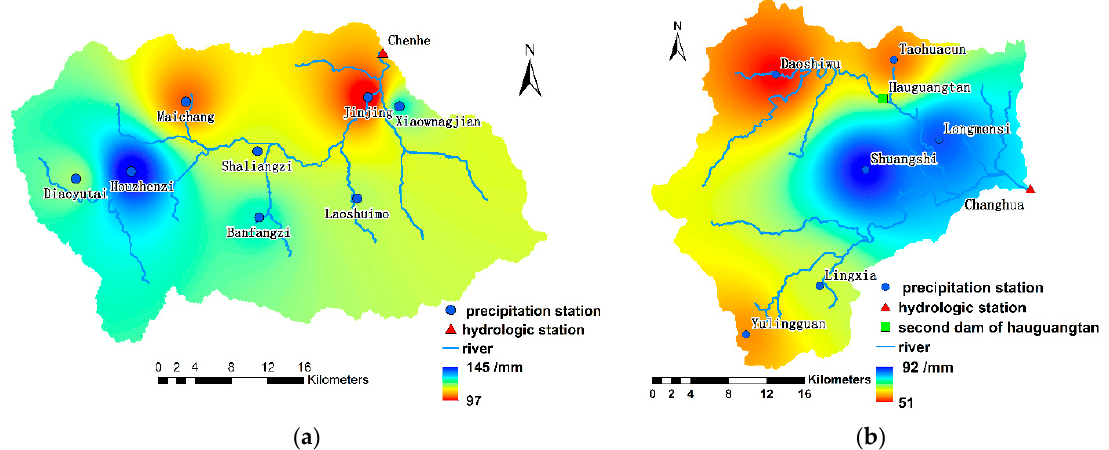
Figure 7. Rainfall distribution during the flood periods: ( a ) 3–9 September 2003 (Chenhe Watershed); ( b ) 27 June–1 July 2002 (Changhua Watershed).